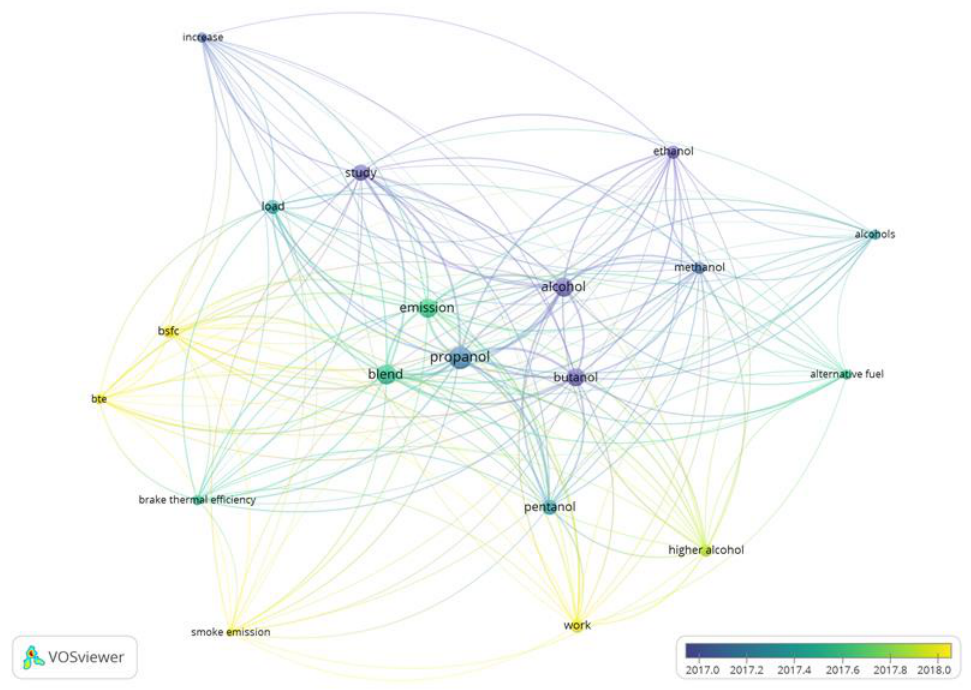
Figure 4. Research topics provided by Web of Science, Clarivate, including propanol/diesel fuel